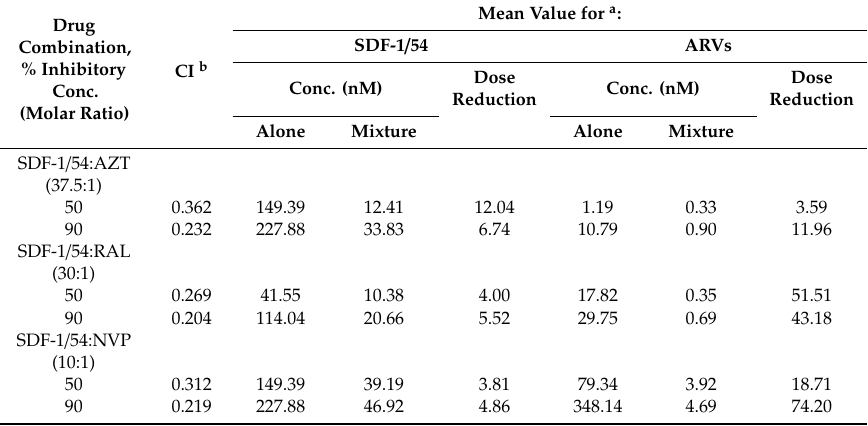
Table 7. Combination index and dose reduction values for inhibition of HIV-1 IIIB infection by combining SDF-1 / 54 with